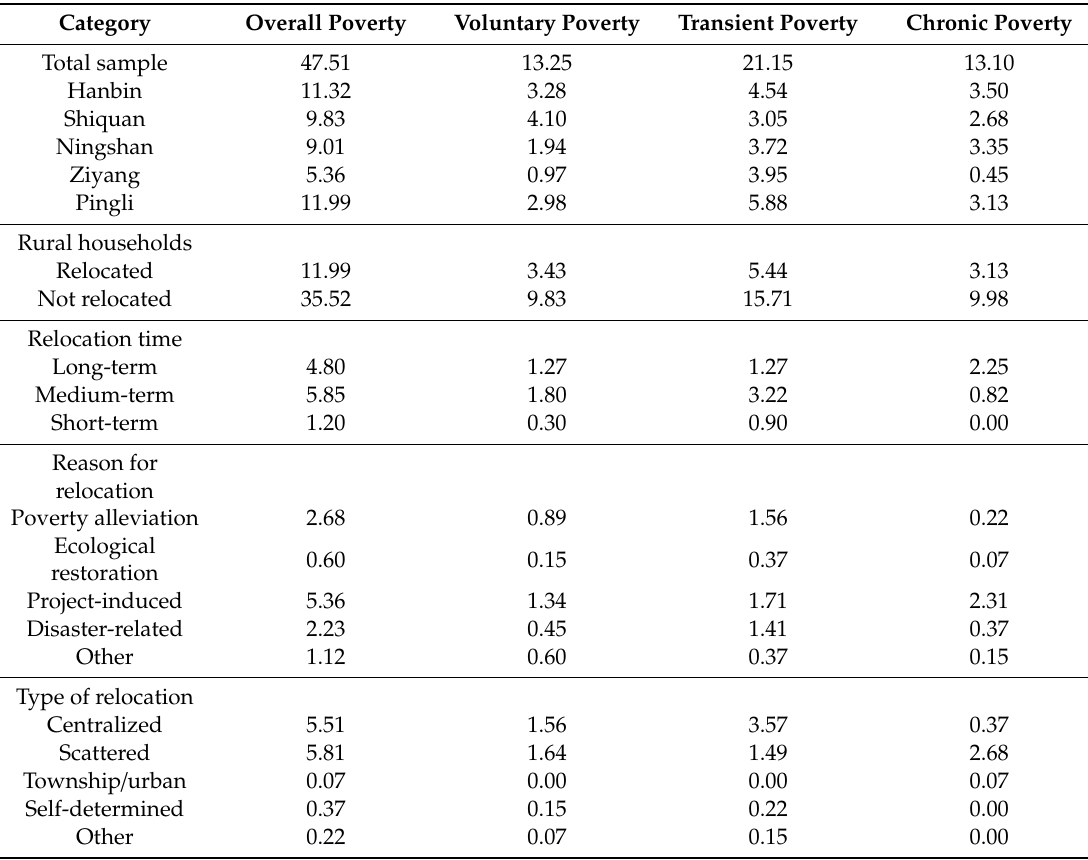
Table 2. Type of poverty in survey area